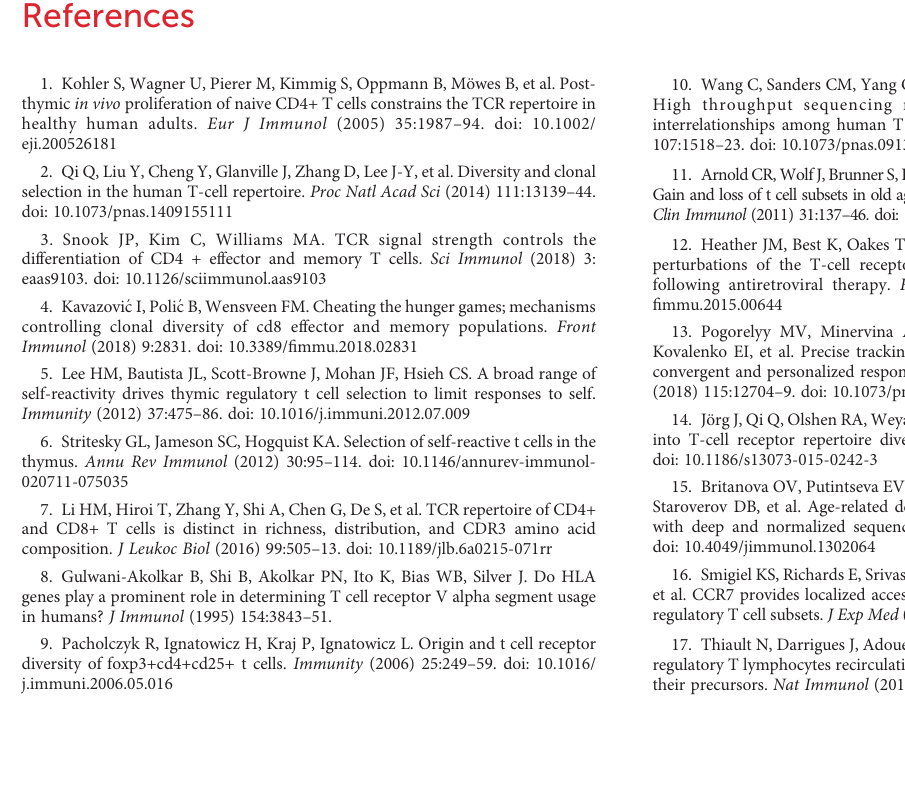
SUPPLEMENTARY FIGURE 4.2 (A) PCAanalysisofthefrequencydistributionsofthemostabundantCDR3 a AA triplets and 7-mers. (B) PCA analysis of the top CDR3 a AA triplets. PCA analysis ofthetop7-mers.CD4+andCD8+repertoiresareplottedseparately,andthe individualpointsarecolouredbytissueoforiginorsubpopulation. (C) Pairwise cosine similarities scores of the top 7-mers CDR3 b AA motifs between individuals (circles) or within individuals (between spleen and bone marrow, triangles).Tcellscompartments(coloreddots)aredividedintoCD4+(left)and CD8+ (right) from young or adult mice. Mean is shown by horizontal grey lines. SUPPLEMENTARY FIGURE 4.3 Differential CDR3 b AA 7mer frequency in CD4+ Treg and CD4+ Teff TCRs. (A) Each dot represents a single CDR3 b AA 7-mer motif. P-value (t-test) was calculated for each motif across six samples (three mice and two tissues) of CD4+TregandCD4+effectorcells.TheY-axisshowsFDR-adjustedp-values. TheX-axisshowsthelog2-fold-change,calculatedbetweenTregandCD4+ effector mean motifs frequency across compartments (6 samples each). Signi fi cance thresholds are marked by the blue lines at y=1.3 (equivalent to a p-value of 0.05) and x= ± 1 (denoting a total fold-change of 2). Representative 7-mers above both thresholds are labeled with red text and dots. (B) The TCRV b usage of the CD4+Treg (right) and CD4+ effector (left) differentially expressed 7-mers. The color represents the log10 frequency of each 7-mer in a speci fi c V b gene (low= blue, high=red). SUPPLEMENTARY FIGURE 5.1 (A) The Davies-Bouldin (DB) index applied to CDR3 b AA top triplet motifs, capturing the average separability (ratio of the within-cluster variance to the separationbetweenclustercentroids(lowerscoremeansbetterclustering)of clusters of different repertoires from their nearest counterpart. A reference distribution adding random clustering features (2 or 4 variables, red and blue lines respectively) to the same data and repeated the DB index calculation 10000times. (B-C) VgenesimilarityplottedagainstCDRAAtoptripletsimilarity distributioninyoungvs.adultoryoung.The b chainsequencesofallpaircosine